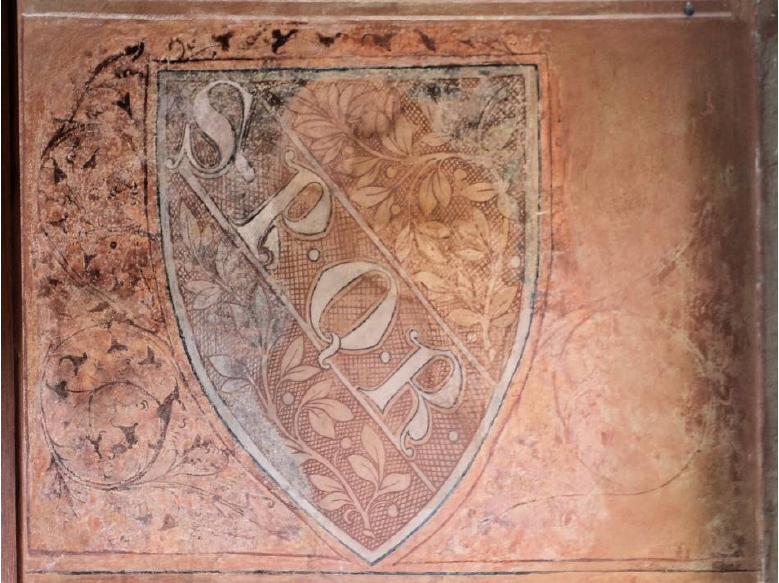
Figure 7. Karlštejn, coat of arms with the inscription ‘S.P.Q.R.’. Mid-14th century. Photo by František